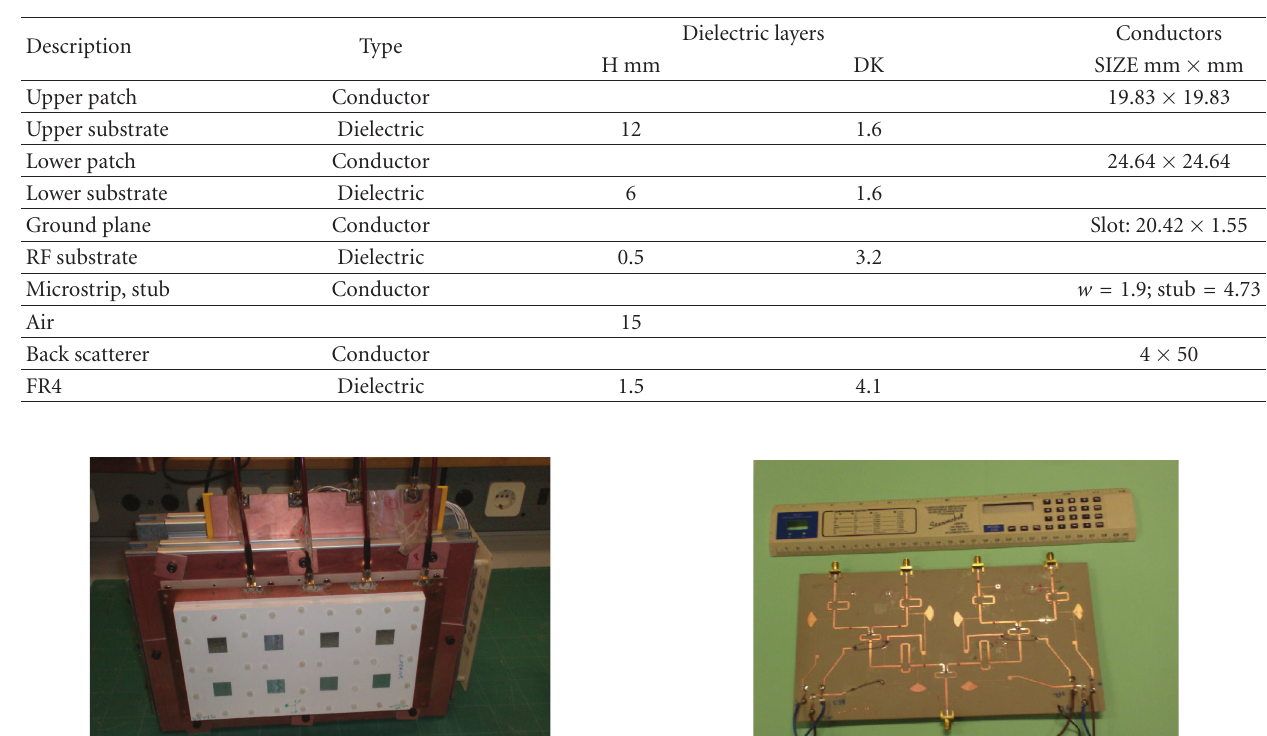
Table 1: Definition of the lay-up for the radiating element.